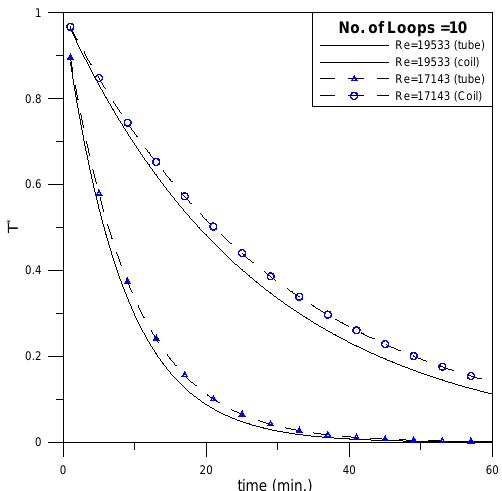
Figure 8. Temperature variation predicted by 1-D coiled-type and experiment.